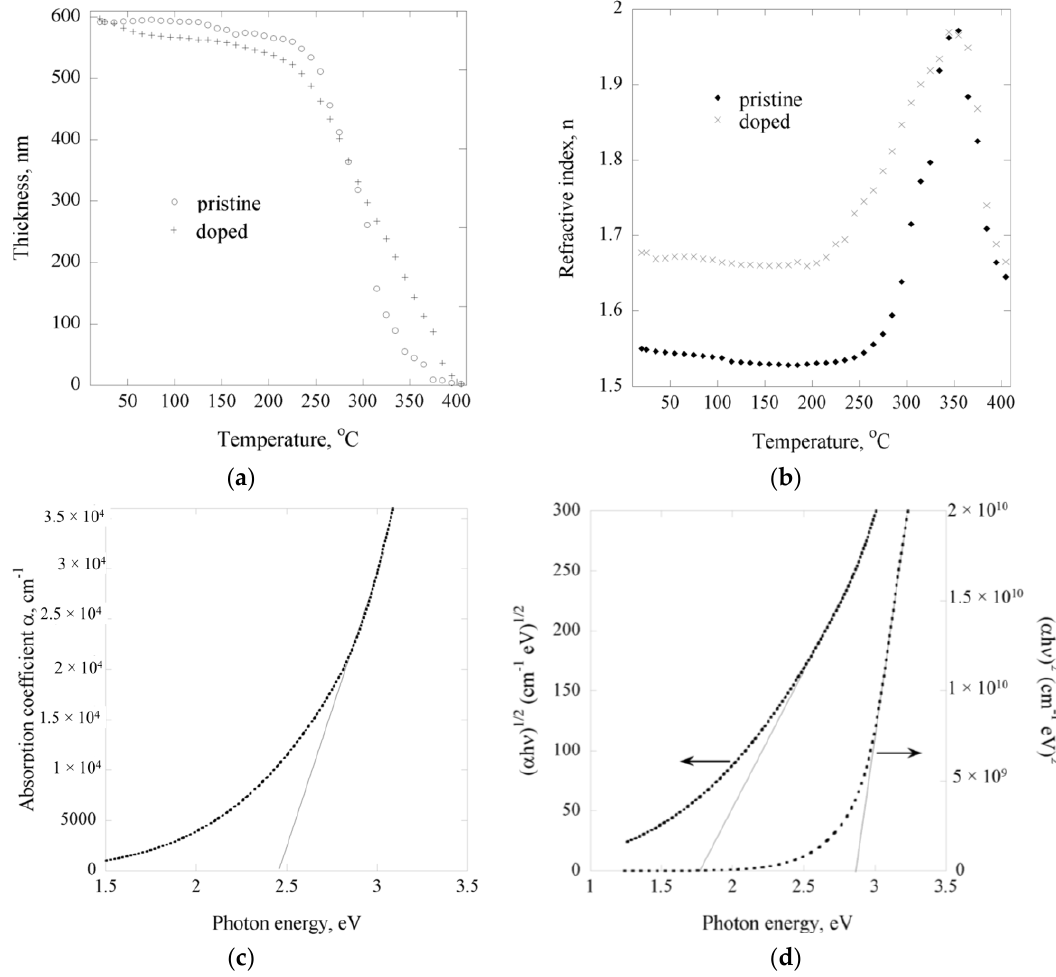
Figure 3. ( a ) Film thickness and ( b ) dynamic refractive index of pristine and iodine-doped polyterpenol film as a function of annealing temperature; ( c ) band gap and ( d ) direct allowed and indirect allowed transition energies of iodine doped polyterpenol thin films heat treated at 100 °C for 5 h.